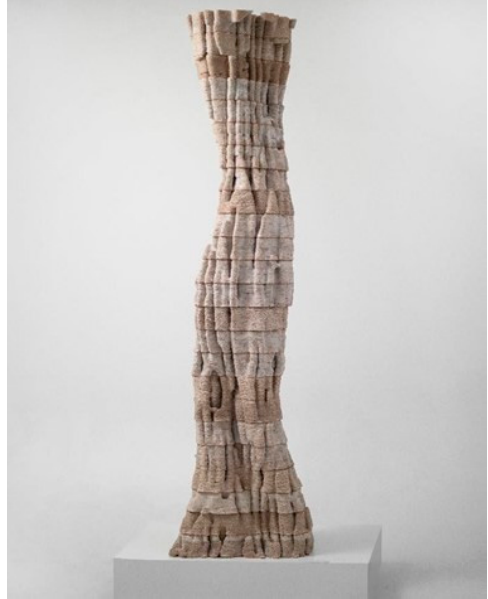
Figure 3. The Pulp Faction Prototype (Image credit: Ana Goidea).